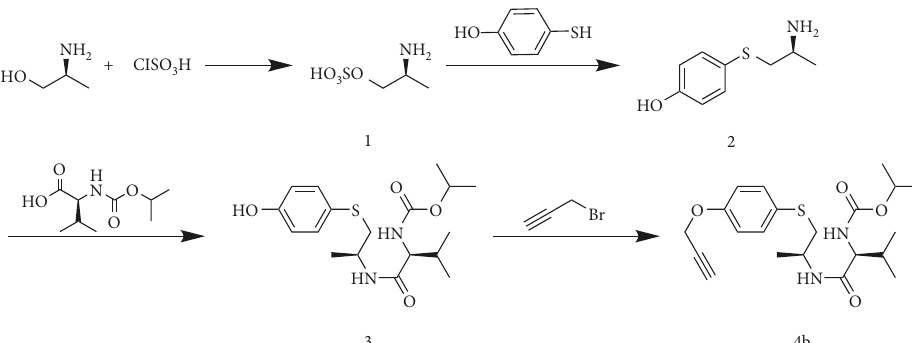
Scheme 1: The synthetic route of compound 4b .